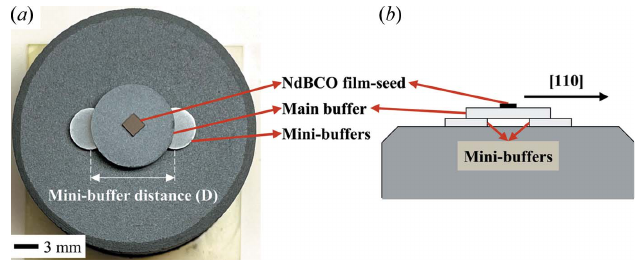
Figure 3 ( a ) Photograph of an initial ISSA seeding architecture with D = 10 mm. ( b ) Schematic showing the side view of film-seed/main-buffer/mini- buffers